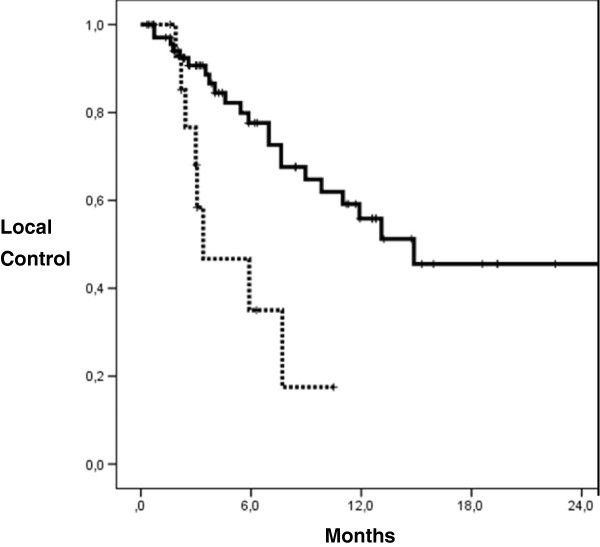
Actuarial LC probability according to EQD2 calculated by Kaplan-Meier (log-rank test; p=0.004). EQD2 > 35 Gy (m=73): continuous line, EQD2 ≤ 35 Gy (m=15): dotted line.